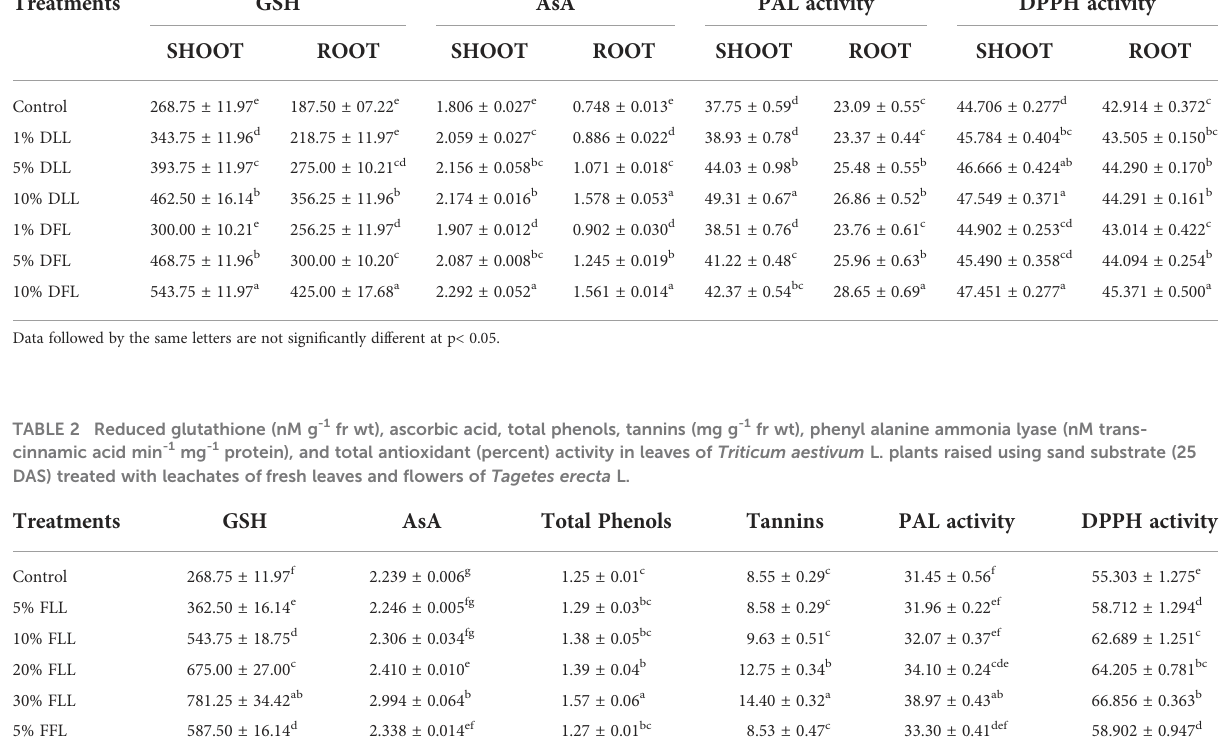
TABLE 1 Reduced glutathione (nM g -1 fr wt), ascorbic acid (mg g -1 fr wt), phenyl alanine ammonia lyase (nM trans-cinnamic acid min -1 mg -1 protein), and total antioxidant (percent) activity in Triticum aestivum L. seedlings (7 DAS) treated with leachates of dry leaves and fl owers of Tagetes erecta L.